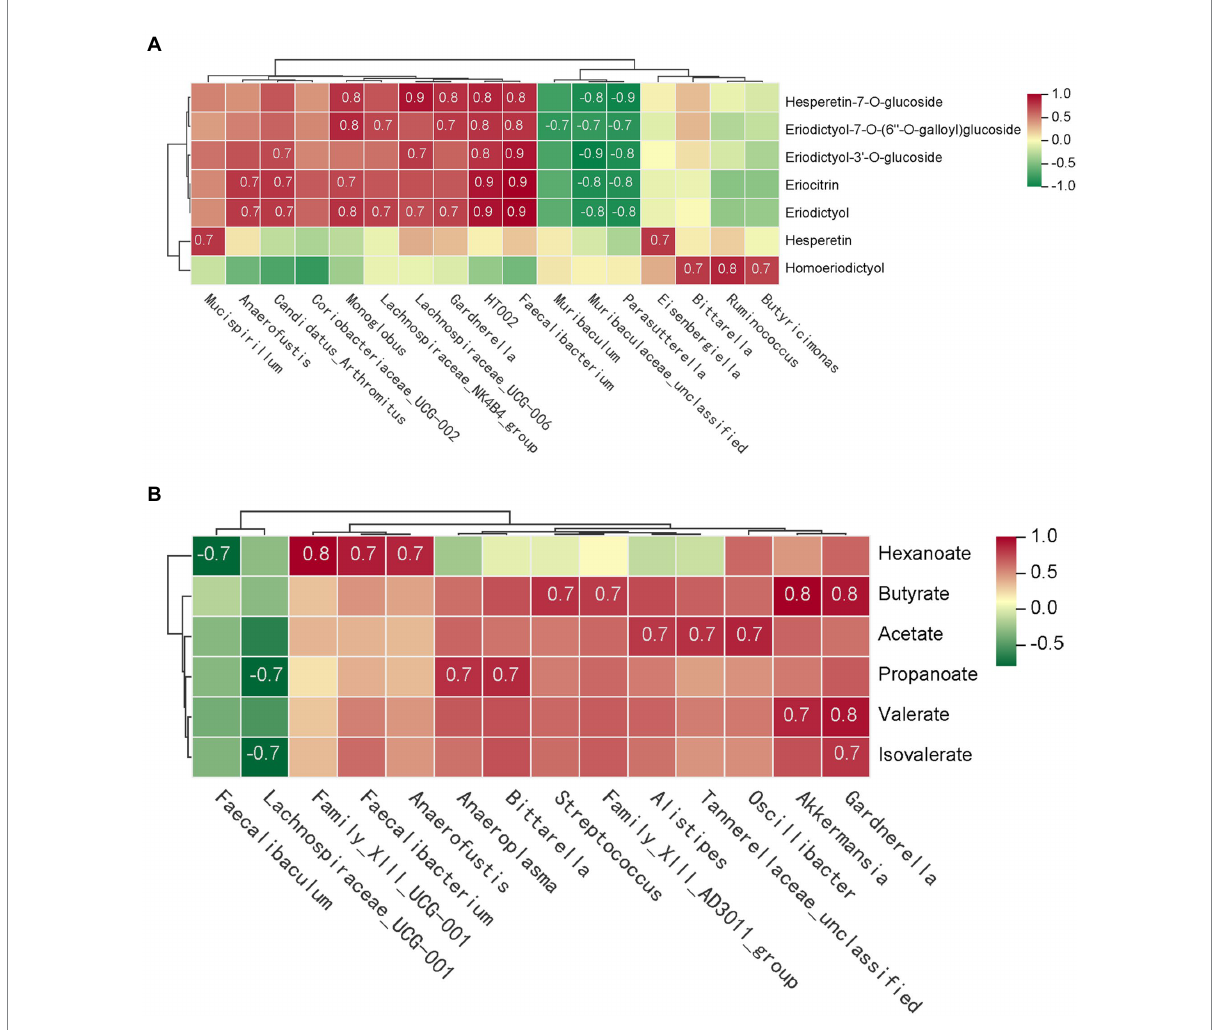
FIGURE 5 Correlation analysis of gut microbiota and metabolites. The matrices were derived from euclidean distance-based bi-clustering of spearman’s rank correlation matrices. Correlation coefficients in each square represent positive (red) and negative (blue) relationships. Colors are proportional